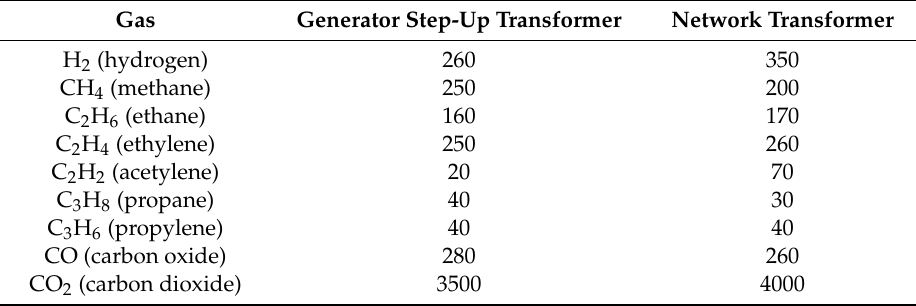
Table 1. Typical gas concentrations in ppm according to [16].